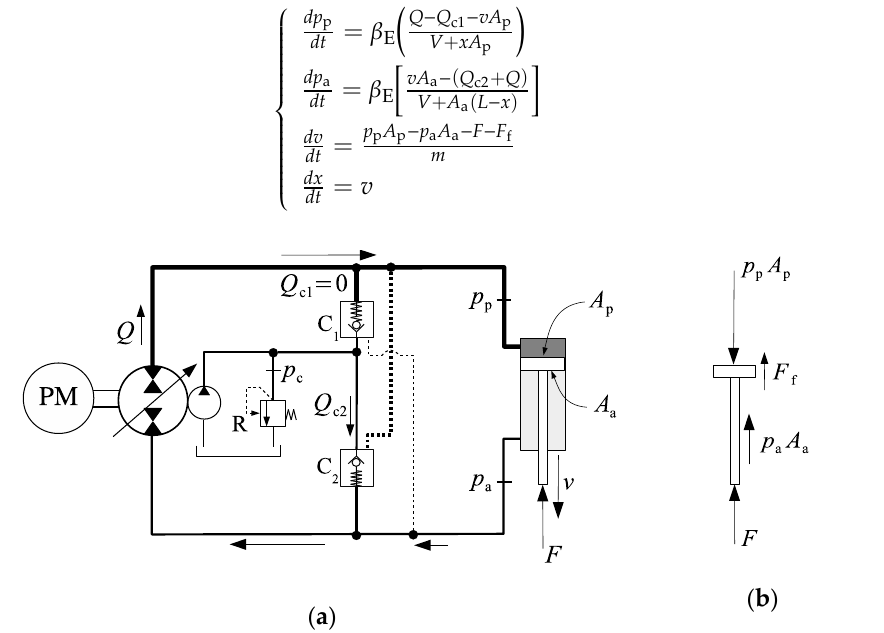
Figure 5. First quadrant operation of the circuit shown in Figure 1a: ( a ) operational diagram; ( b ) forces acting on the piston and rod.